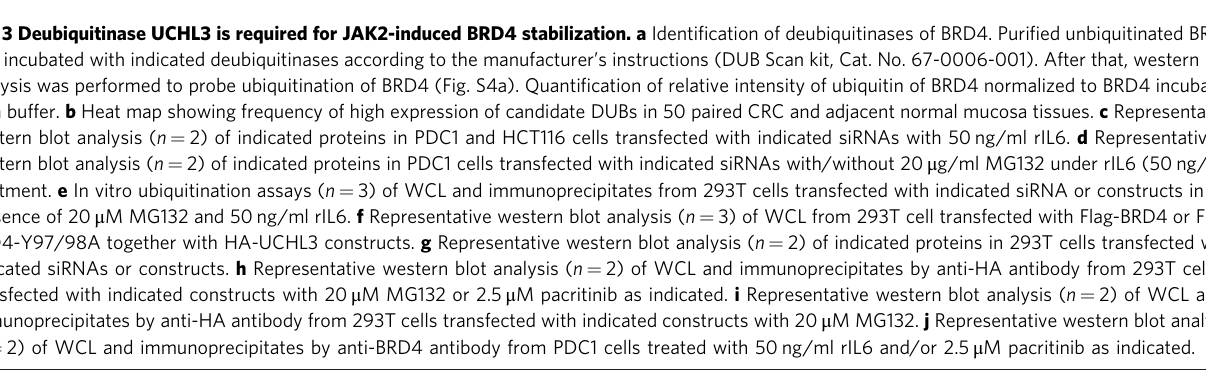
Fig. 3 Deubiquitinase UCHL3 is required for JAK2-induced BRD4 stabilization. a Identi fi cation of deubiquitinases of BRD4. Puri fi ed unbiquitinated BRD4 was incubated with indicated deubiquitinases according to the manufacturer ’ s instructions (DUB Scan kit, Cat. No. 67-0006-001). After that, western blot analysis was performed to probe ubiquitination of BRD4 (Fig. S4a). Quanti fi cation of relative intensity of ubiquitin of BRD4 normalized to BRD4 incubated with buffer. b Heat map showing frequency of high expression of candidate DUBs in 50 paired CRC and adjacent normal mucosa tissues. c Representative western blot analysis ( n = 2) of indicated proteins in PDC1 and HCT116 cells transfected with indicated siRNAs with 50 ng/ml rIL6. d Representative western blot analysis ( n = 2) of indicated proteins in PDC1 cells transfected with indicated siRNAs with/without 20 μ g/ml MG132 under rIL6 (50 ng/ml) treatment. e In vitro ubiquitination assays ( n = 3) of WCL and immunoprecipitates from 293T cells transfected with indicated siRNA or constructs in the presence of 20 μ M MG132 and 50 ng/ml rIL6. f Representative western blot analysis ( n = 3) of WCL from 293T cell transfected with Flag-BRD4 or Flag- BRD4-Y97/98A together with HA-UCHL3 constructs. g Representative western blot analysis ( n = 2) of indicated proteins in 293T cells transfected with indicated siRNAs or constructs. h Representative western blot analysis ( n = 2) of WCL and immunoprecipitates by anti-HA antibody from 293T cells transfected with indicated constructs with 20 μ M MG132 or 2.5 μ M pacritinib as indicated. i Representative western blot analysis ( n = 2) of WCL